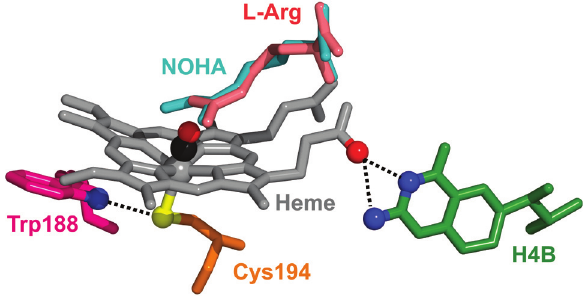
active site (pdb codes oxy